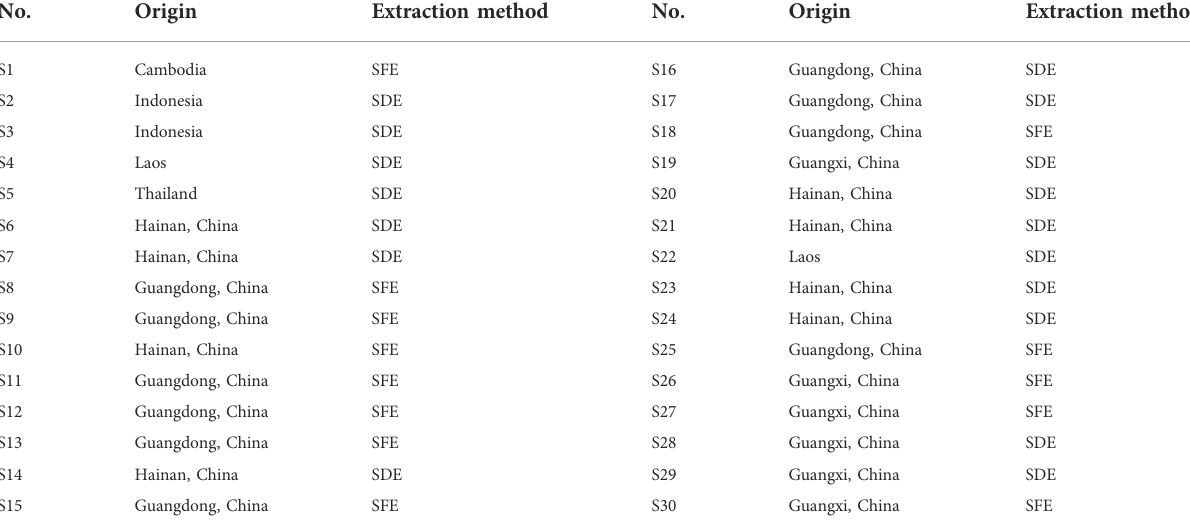
TABLE 1 Geographical origins and extraction methods of 30 batches of AEO samples.